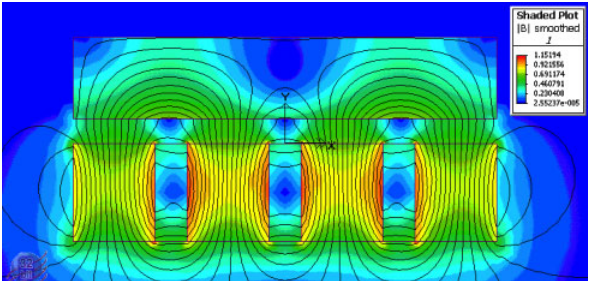
Figure 18 The magnetic flux and flux